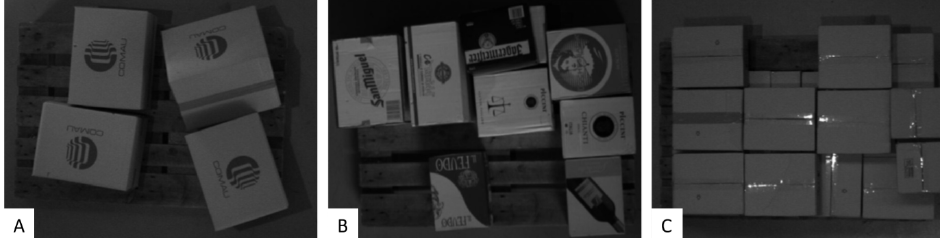
Figure 2. Sample image of Dataset 1 ( A ). Sample image of Dataset 2 ( B ). Sample image of Dataset 3 ( C